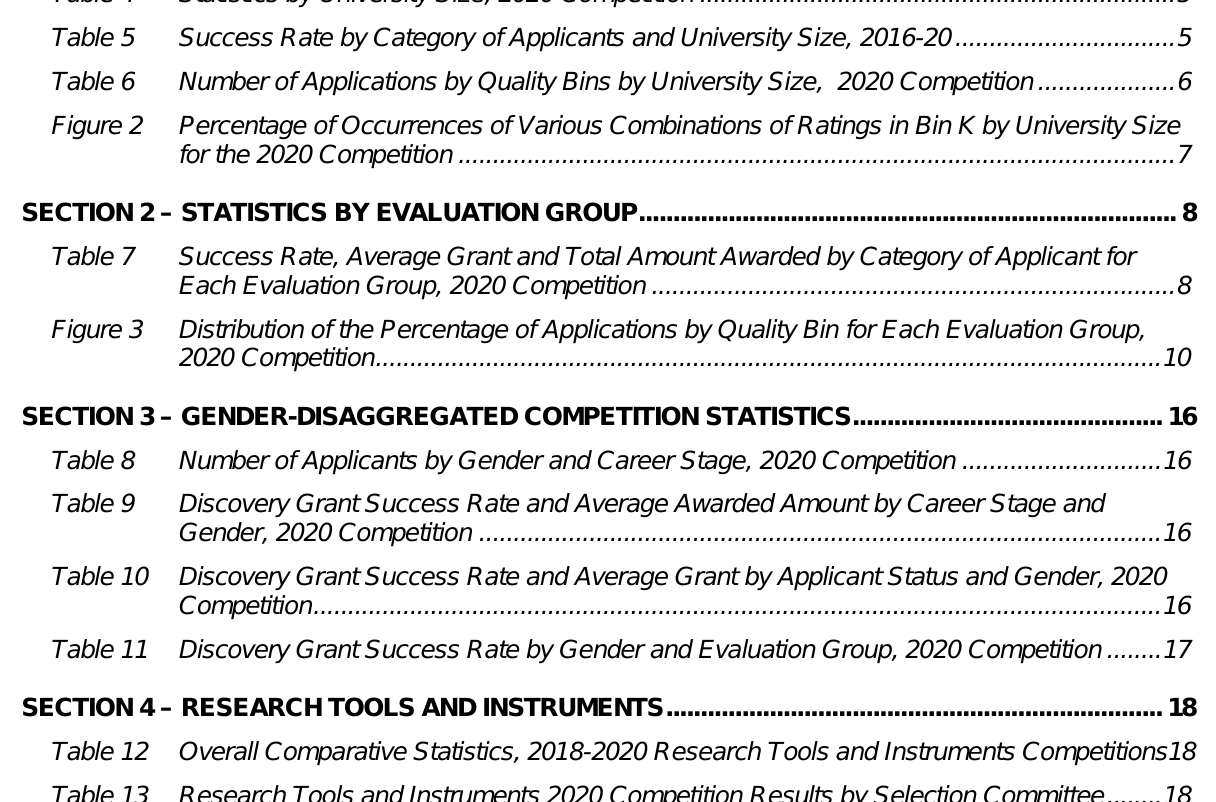
Discovery Grants Competition Results by University (including Affiliated University